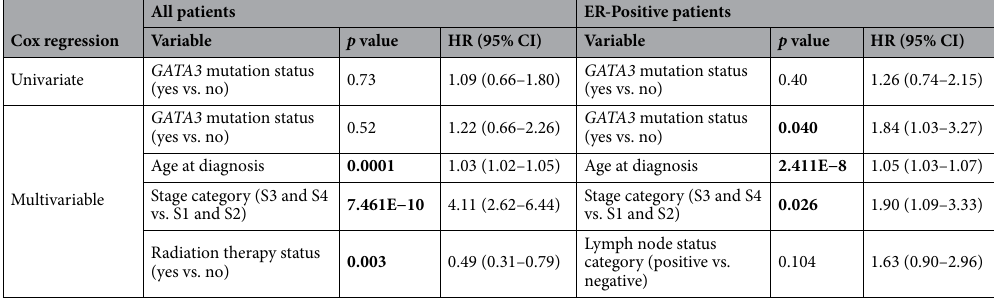
Table 3. Results of the univariate and multivariable Cox regression analysis for GATA3 mutation status. CI confidence interval, HR hazards ratio.